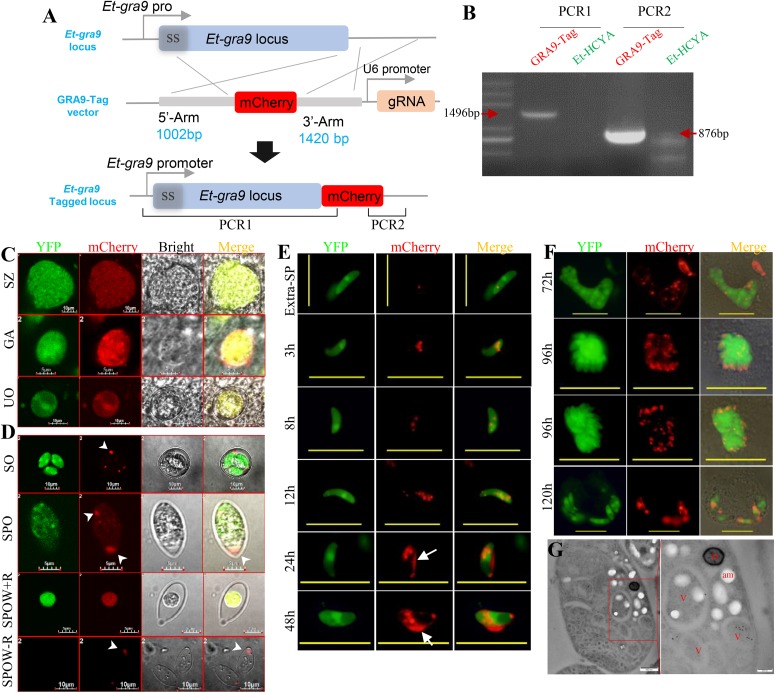
C-terminal tagging of Etgra9 mediated by CRISPR/Cas9 and the observation of expression pattern of tagged Etgra9 in parasites. (A) Schematics showing CRISPR/Cas9-mediated targeting of Etgra9 gene. Et-HCYA were transfected with GRA9-Tag vector, which contains a U6-gRNA cassette and a homologous recombination cassette with mCherry fused to the C-terminal of Etgra9 gene. (B) Oocysts with yellow and mCherry fluorescence were sorted by FACS, then genomic DNA was extracted for PCR identification. (C) Localization of mCherry-tagged EtGRA9 in different developmental stages in vivo. The cecal smears were prepared at 96, 120, and 156 h.p.i. for the detection of merozoites, gametocytes, and unsporulated oocysts, respectively. UO, unsporulated oocyst; SZ, schizont; and GA, gametocyte. (D) Localization of mCherry-tagged EtGRA9 during excystation. Sporocyst (SPO) were released from sporulated oocyst (SO) by glass beads grinding, and sporozoites (Extra-SP) were excysted after bile-trypsin digestion, resulting empty sporocyst wall with (SPOW + R)/without (SPOW–R) residue body. Sporozoites were observed at different time points after being inoculated onto MDBK cells (E,F). White arrowheads show EtGRA9 in Stieda bodies and dense granule; white arrows show EtGRA9 secreted into the parasitophorous vacuole. The localization of EtGRA9 was also observed by immune-electron microscopy (G). The ultrathin sections of purified second generation merozoites were labeled with anti-mCherry antibody and followed by immunogold labeling. D, dense granule; V, vesicle; am, amylopectin. Bars in panels C, D, and G are indicated in graph, and bars are 20 μm in panels E and F.